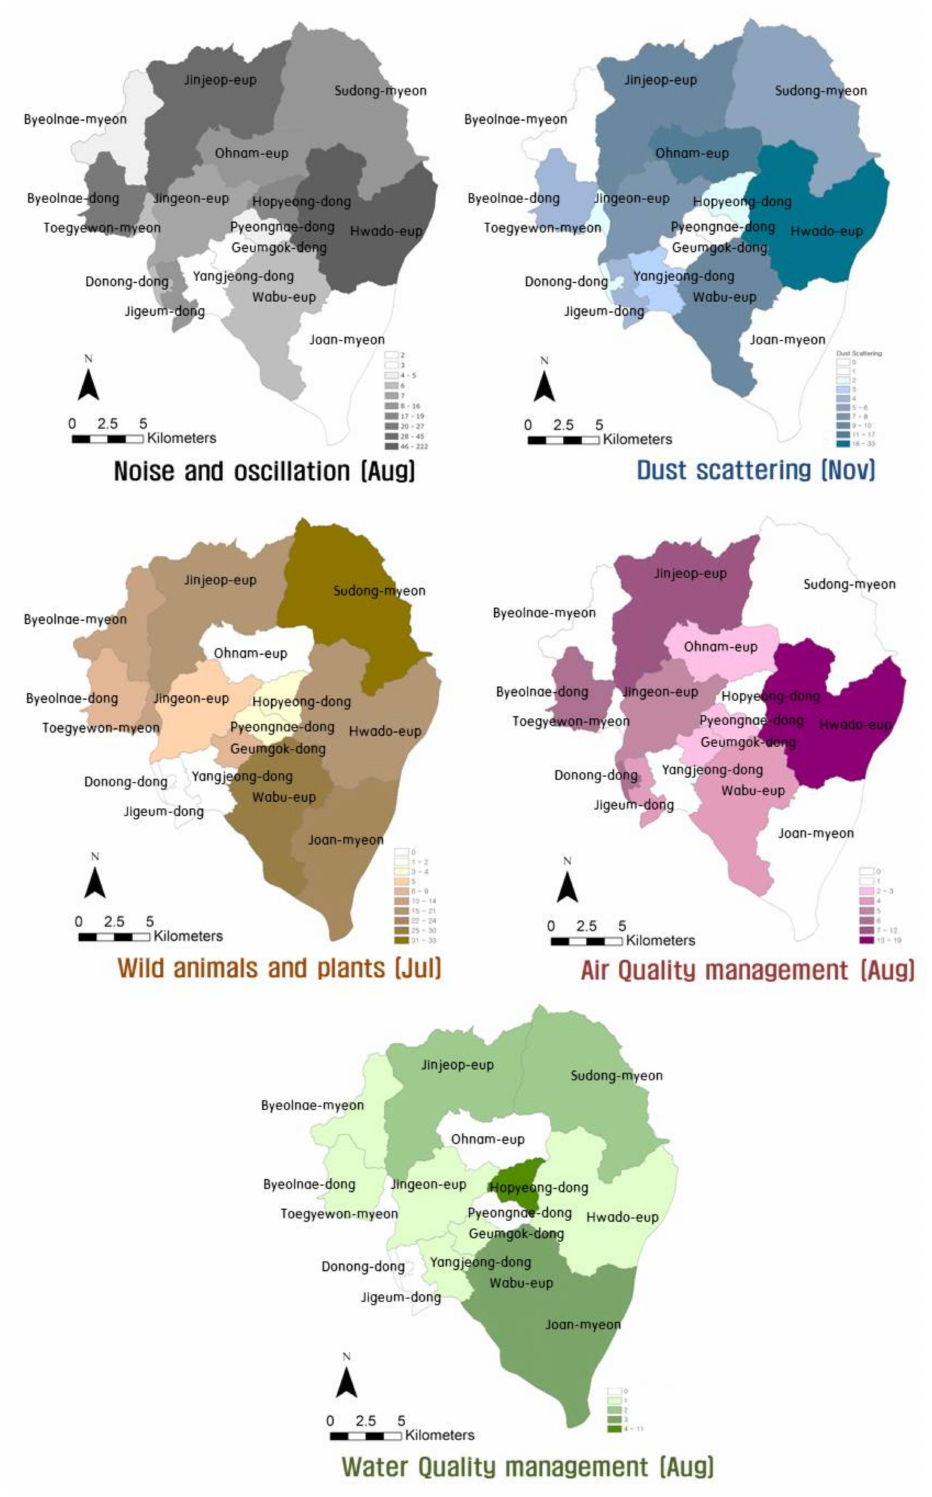
Figure 4. Complaints by municipal areas in the month where the most complaints were